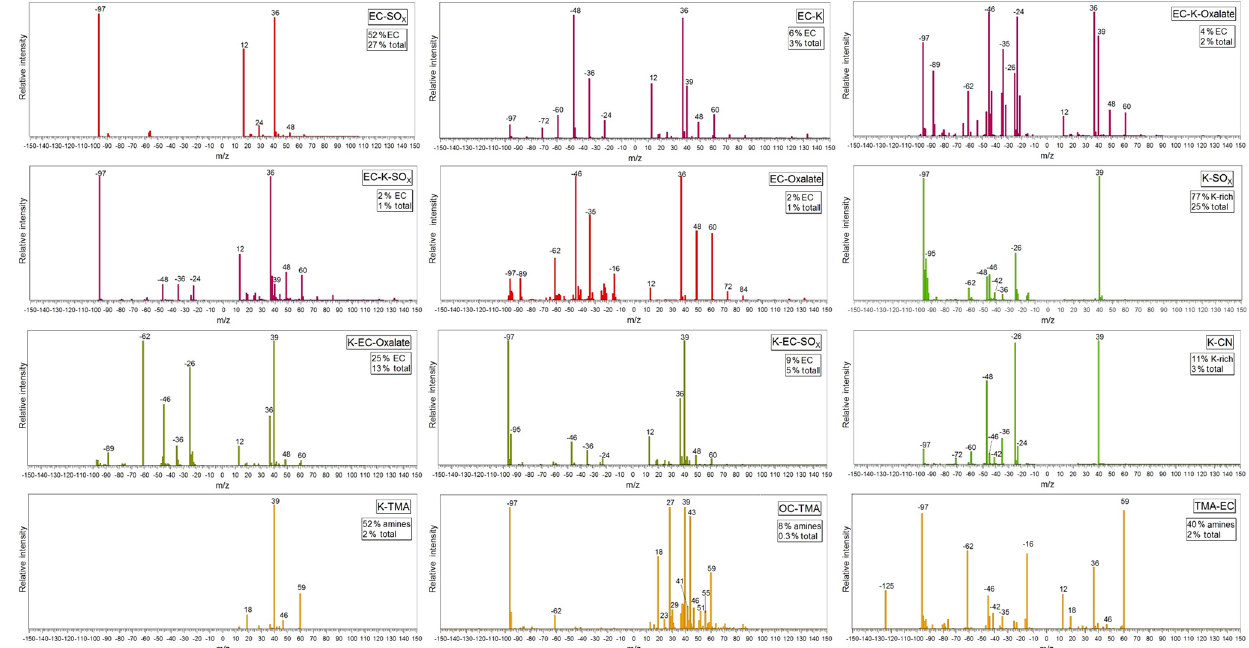
Figure 3. Average mass spectra of ATOFMS particle classes originating from regionally transported combustion sources during ADRIMED and SAF-MED. Percentages refer to a fraction of ATOFMS category and total particle